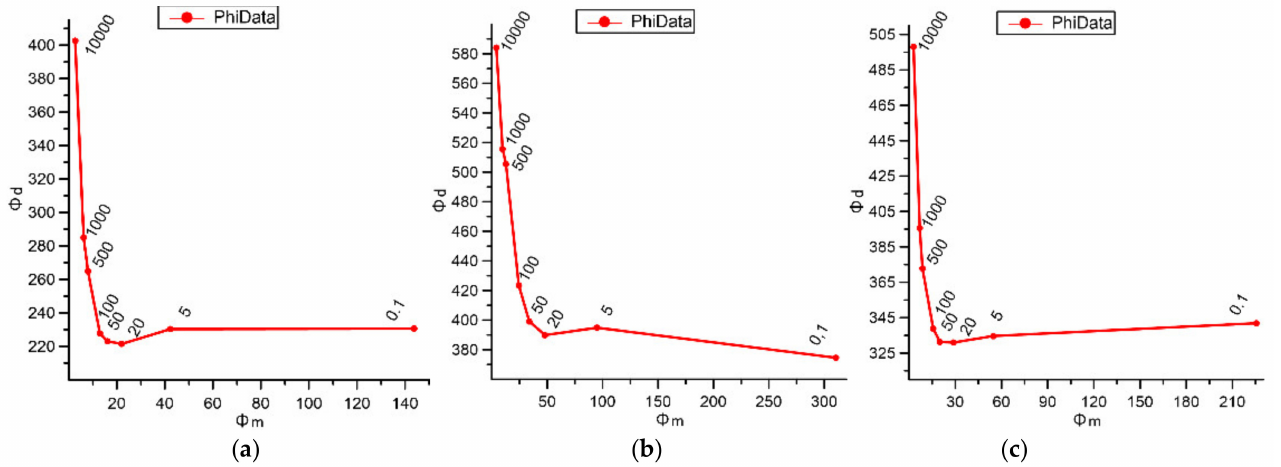
Figure 9. L curve analysis, which is based on the data object function ( φ ; d ) and the model object function ( φ ; m ), was used to select the optimal regularization factor (tau). The numbers shown on the curve are the regularization factors used in the inversions. ( a ) L1 profile, ( b ) L2 profile, and ( c ) L3